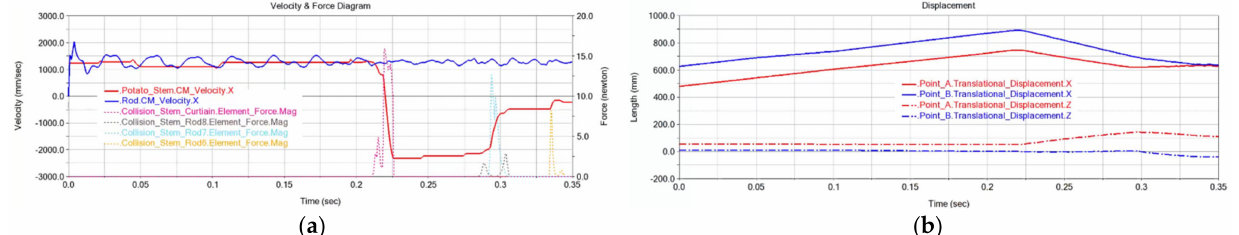
Figure 10. Simulation data exported from admas. ( a ) Velocity and force diagram of stem transported- posture adjustment process. ( b ) Displacement diagrams of the A and B marker points of the stem in the x − axis direction and z − axis